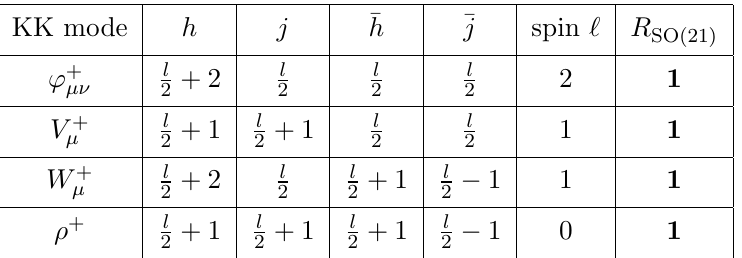
Table 1 . Kaluza Klein modes from the spin-2 multiplets (cid:0) l . We have kept only the relevant